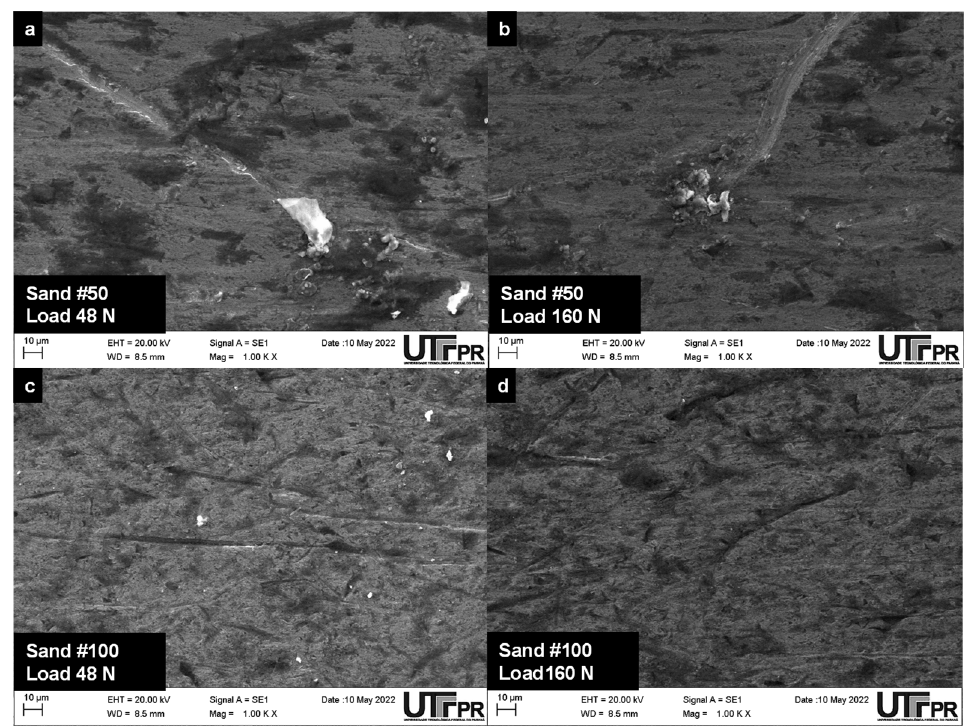
Figure 9. SEI SEM of Fe-Cr-C-V coatings (12.5 mm) tested with ( a ) sand #50 load 48 N, ( b ) sand #50